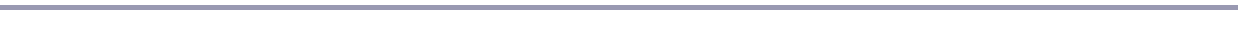
Fig. 5. Eight criteria required to be met for three consecutive years within seven home ranges intended for nesting by the light-footed clapper rail, a U.S. federally endangered species. Monitoring of specific objectives in low, middle, and high marsh habitats at Sweetwater Marsh, California, showed that several criteria were met (shaded cells), but critical criteria were unmet in 1996 and 1997, notably tall cordgrass for nest construction and camouflage (black